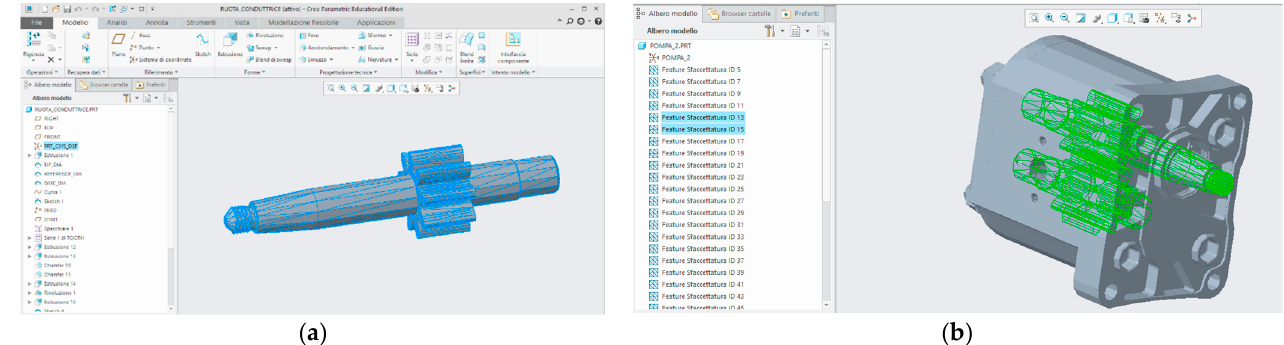
Figure 14. ( a ) Drive gear exported in obj form. ( b ) Hydraulic pump exported in obj